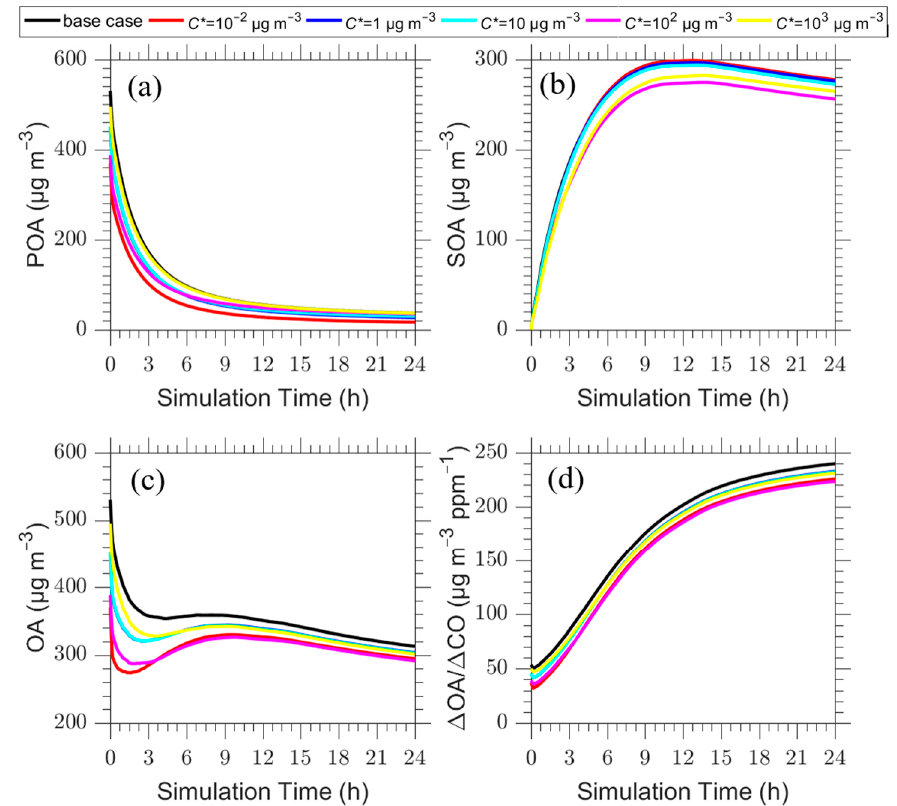
Figure 6. Time series of: ( a ) POA; ( b ) SOA; ( c ) total OA; and ( d ) Δ OA/ Δ CO for the plume centerline after zeroing the emissions in the C * =10 − 2 μ g m − 3 ( red line ), 1 μ g m − 3 ( blue line ), 10 μ g m − 3 ( cyan line ), 10 2 μ g m − 3 ( magenta line ), 10 3 μ g m − 3 ( yellow line ) and the base case ( black line ).